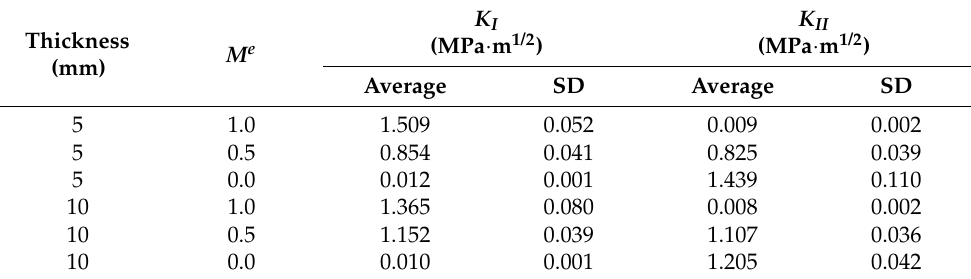
Figure 3. Mode I and II dimensionless stress intensity factor at various incline crack angles. Table 2. Average mixed-mode I/II fracture toughness of PMMA.